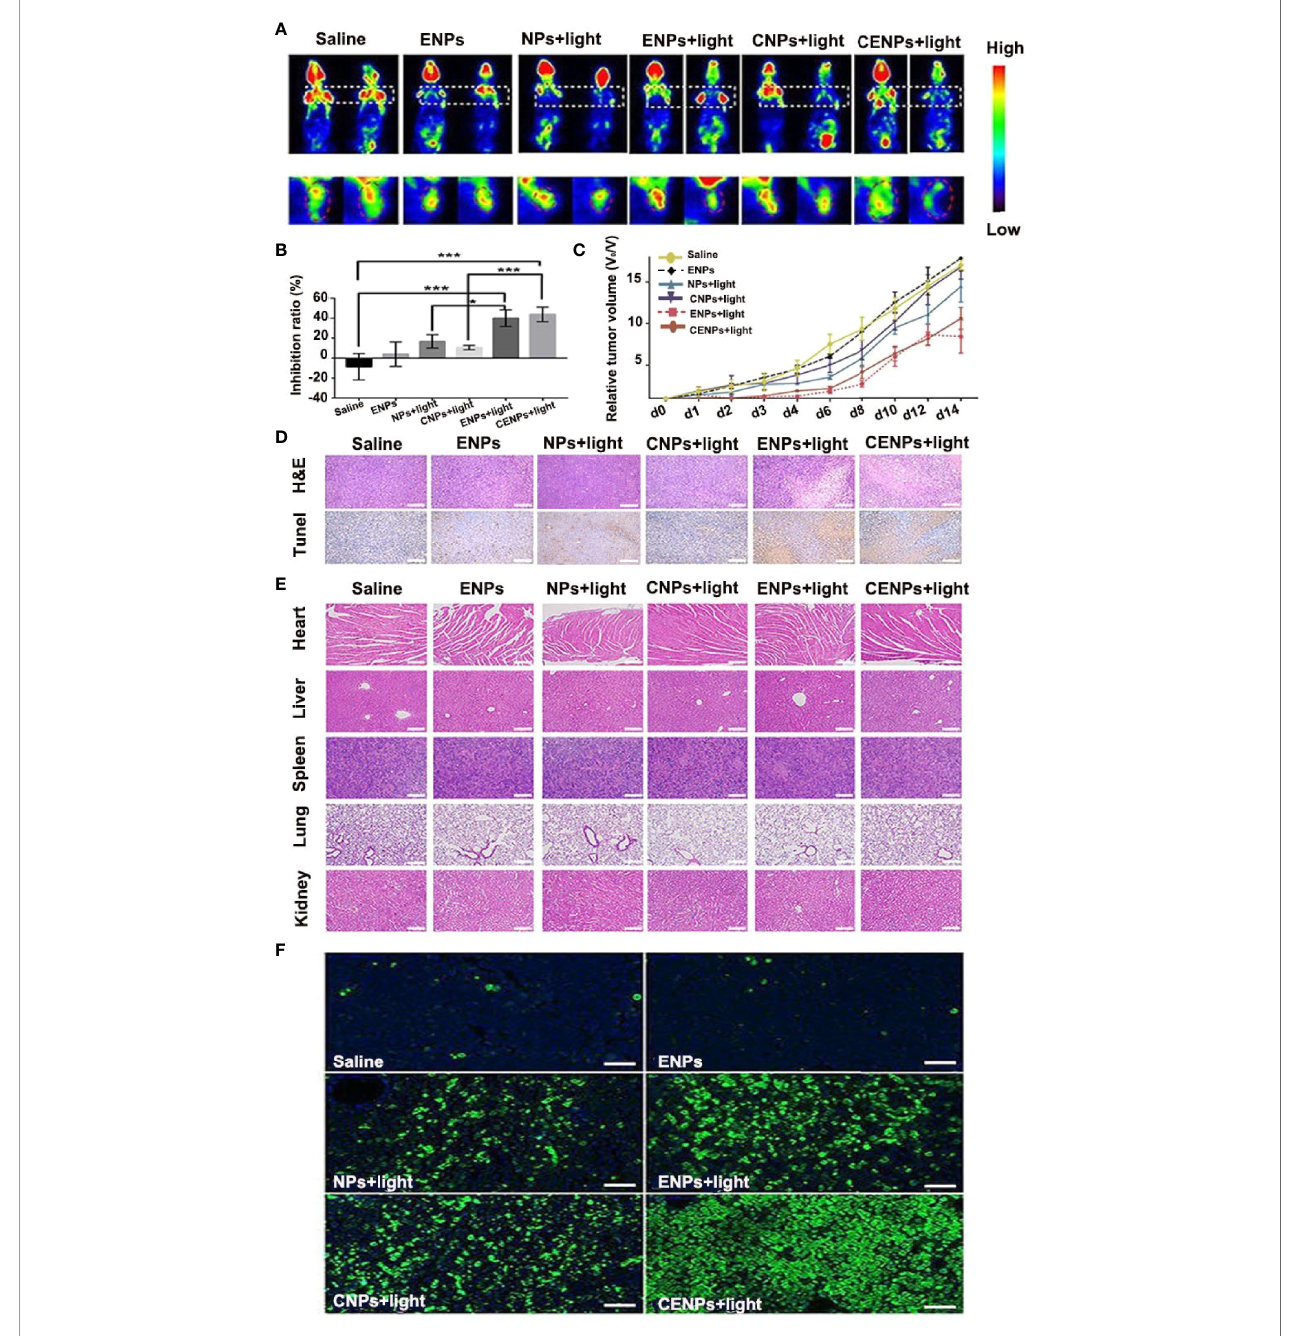
FIGURE 8 | The antitumor effect and safety evaluation in vivo . Sections (A – E) correspond to the Raji mouse model. (A) PET imaging performed 24 h before and 24 h after PDT treatment. (B) Quantitative analysis of tumor growth inhibition rate by mean radioactivity of 18F-FDG. *p < 0.05, ***p < 0.001. (C) Relative tumor volume variation of mice treated under different conditions. (D) H&E staining and TUNEL staining of tumors at 24 h after PDT treatment. Apoptotic cells were identi fi ed by TUNEL assay (brown) (scale bar 100 m m). (E) H&E stained images of major organ slices (scale bar 200 m m). (F) Tumors at 24 h post-treatment and corresponding TUNEL staining of tumor slides in the Jeko-1 mouse model. (scale bar 50 m